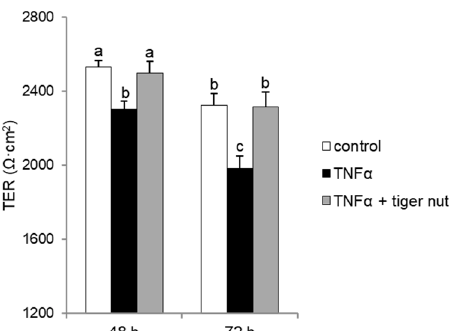
Figure 6. Effect of tiger nut on TER in Caco-2 cells incubated with TNF α . Cultures were incubated for 48 and 72 h in the absence (control) or presence of TNF α (300 ng/mL) and tiger nut (2.5 mg/mL). Results are expressed as the mean ± SEM of n = 12 monolayers. Labeled bars without a common letter differ ( p < 0.05).